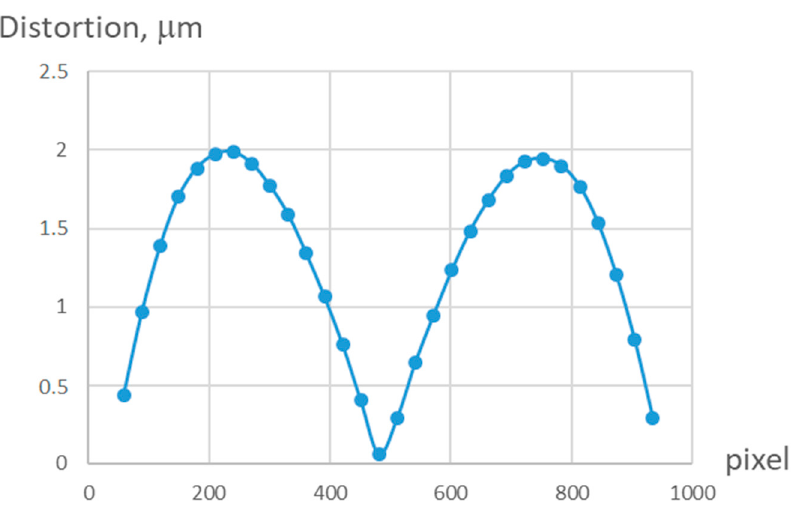
Figure 5. Plot of the central section of the two-dimensional distortion function of the 5th order, calculated from a series of 12 frames.